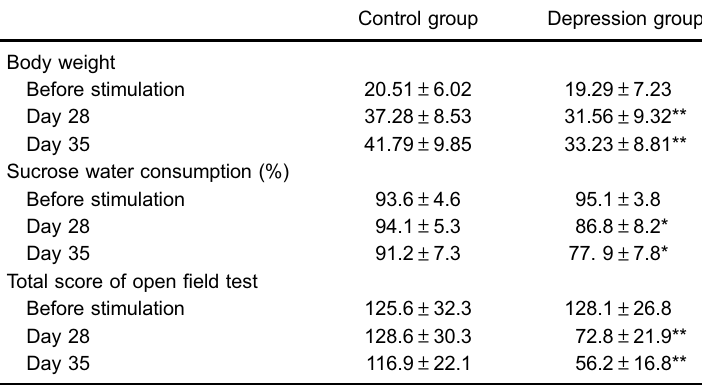
Table 1. Successful construction of mouse depression model.